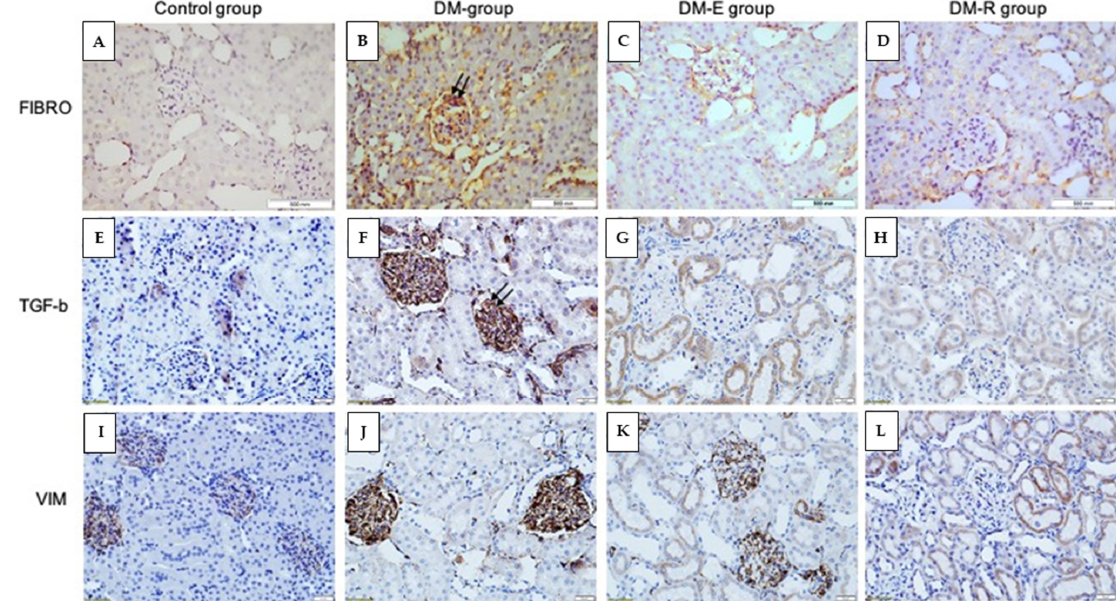
Figure 6. Immunohistochemistry analysis of fibronectin ( A – D ), TGF- β 1 ( E – H ), and vimentin ( I – L ) expression in the studied groups. Representative pictures after immunostaining for fibronectin, TGF- β 1, and vimentin in the Ctrl group ( A , E , I ), DM group ( B , F , J ), enalapril group ( C , G , K ), and DM-R group ( D , H , L ). Note that glomeruli in the DM group show evidence of focal glomerular sclerosis, as indicated by an increased percentage of the stained area (double arrows), whereas in both DM-E and DM-R groups, glomeruli and tubules do not show evidence of injury and look almost similar to glomeruli in the Ctrl group. DM, diabetic non-treated group, DM-E, diabetic enalapril-treated group (10 mg · kg − 1 ), DM-R, diabetic ruxolitinib-treated group (moderate dose of 2.2 mg · kg − 1 ). FIBRO; fibronectin, VIM; vimentin. Original magnifications ×